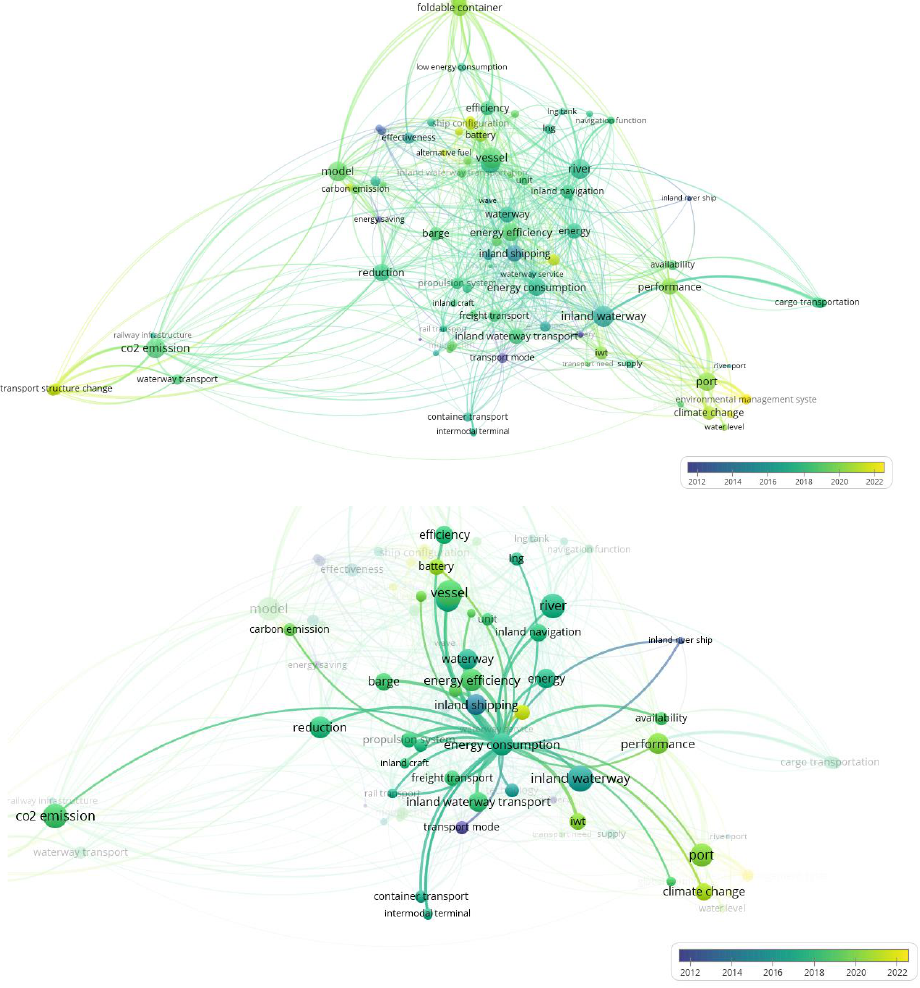
Figure 2. Mapping latent variables from the literature on issues connected with the energy consumption of inland waterway transport. Note: Technical publication on mapping and clustering using VOSviewer [61]. Limitations: The authors did not take into account many valuable publications in the study, instead taking into account the need to narrow the thematic scope of the described